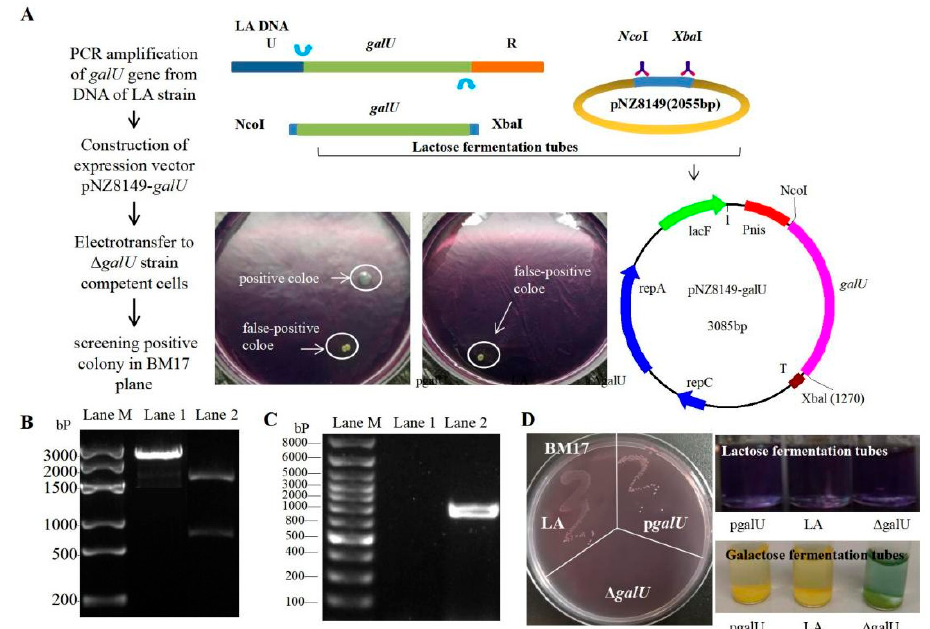
Figure 2. Schematics and results of preparation of the p galU complementation strain. ( A ) Schematics for preparation of the overexpression strain, p galU . ( B )Electrophoresis of recombinant expression plasmid pNZ8149 ‐ galU . Lane M, Marker 3000 bp; Lane 1, fragments of the digested plasmid; Lane 2, plasmid pNZ8149 ‐ galU digested by NcoI ‐ XbaI restriction endonucleases. ( C ) PCR validation of a positive p galU strain, screened on a BM17 plate. Lane M, Marker 8000 bp; Lane 1, a pseudo ‐ positive clone; Lane 2, positive p galU strain. ( D ) BM17 plate colony ( left ) and the lactose/galactose fermentation ( right ) of the LA, Δ galU, and p galU strains.